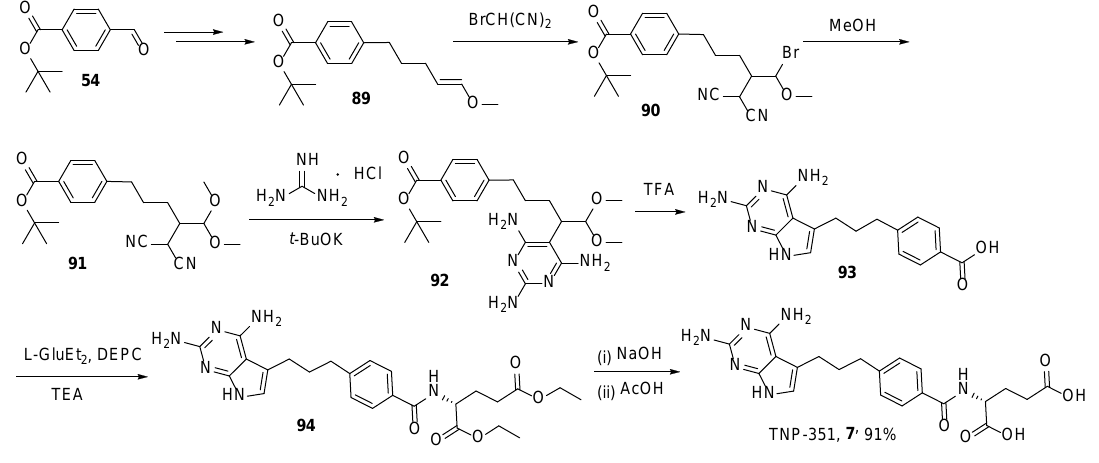
Scheme 29. Multistep synthesis of